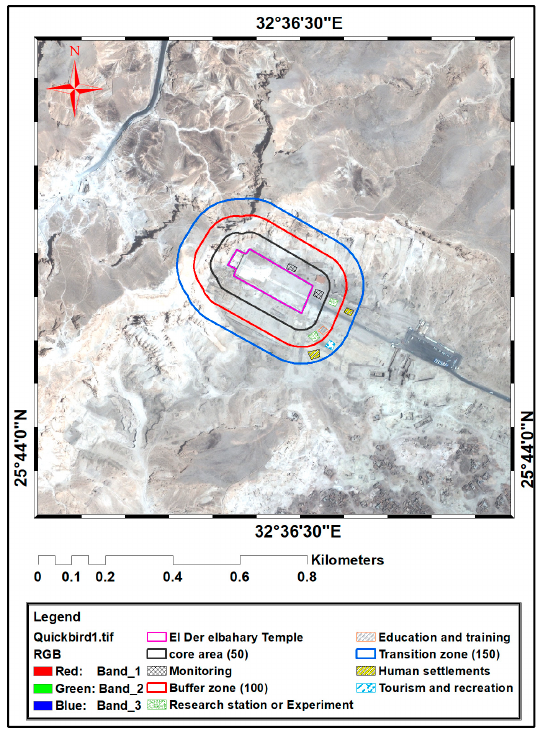
Figure 16. Proposed zonation areas around Hatshepsut temple by Quick bird satellite image 2005 (RGB).